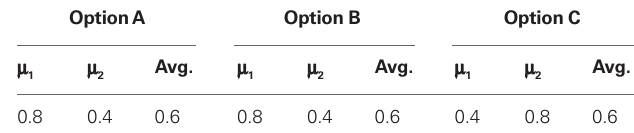
Table 1 | The stimulus condition used in the simulation